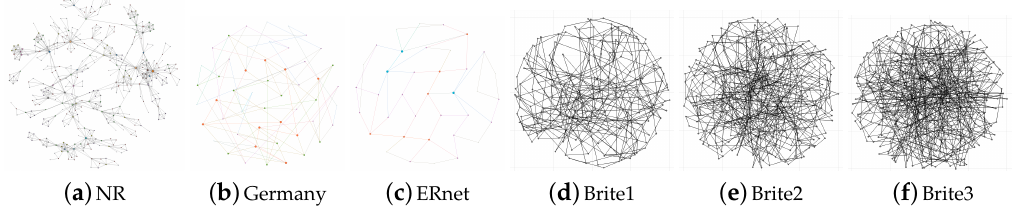
Figure 5. The topologies used to evaluate rapid recovery techniques are illustrated. We evaluate recovery algorithms in terms of their length, operation and latency. The densities of theses topologies are listed in Table